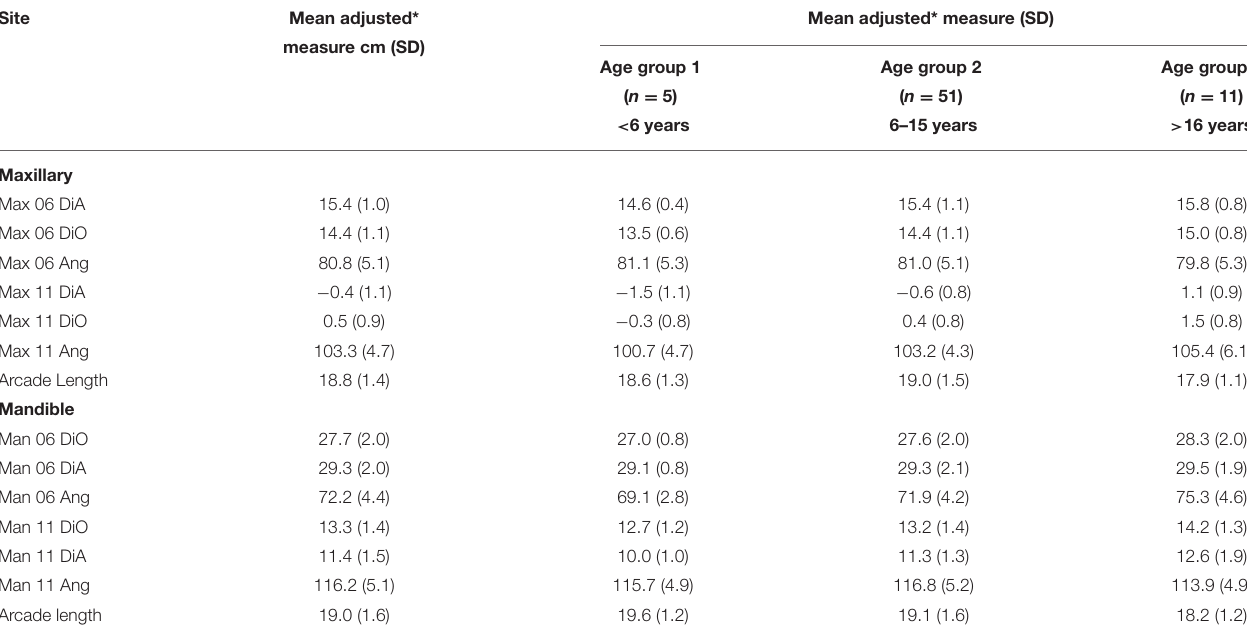
TABLE 3 | Mean adjusted measures (cm) and angles (degrees) for each site from 67 horses subdivided by age groups. Site